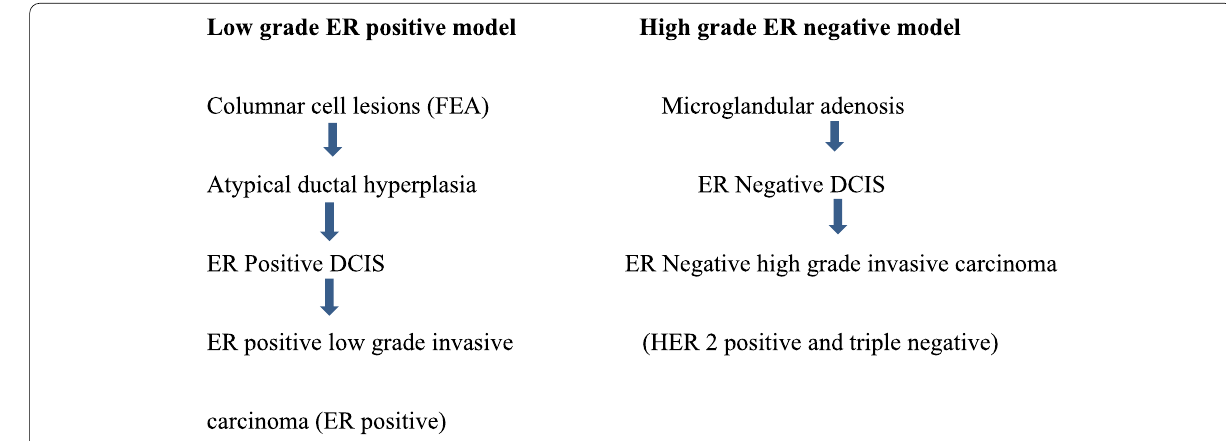
Fig. 1 Diagrammatic representation of the two molecular based breast cancer pathogenetic